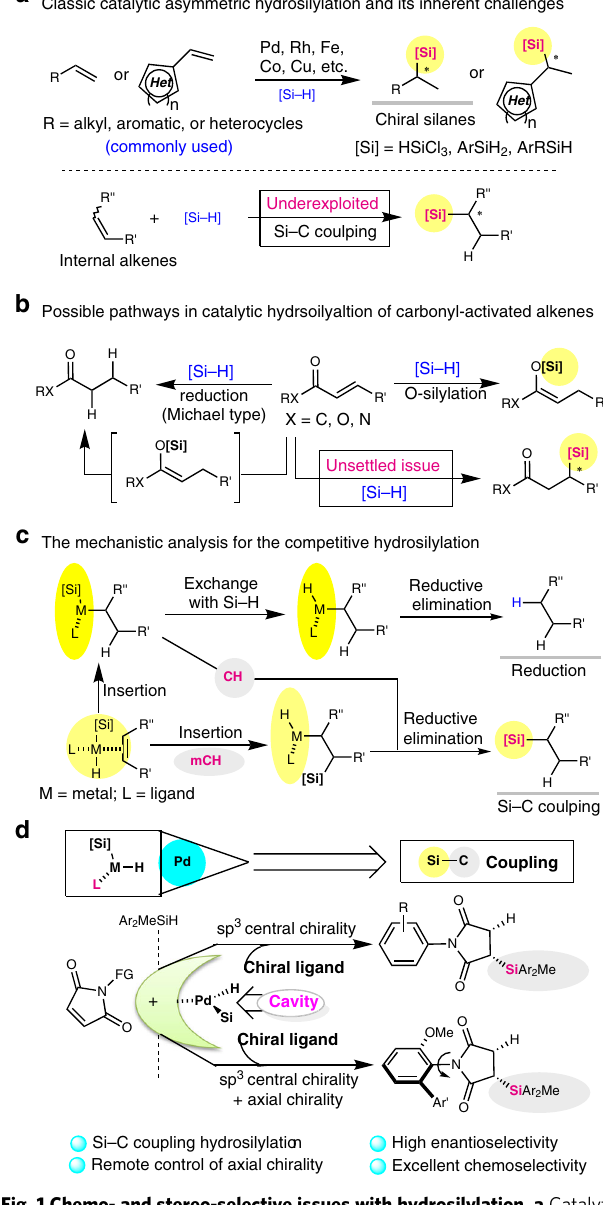
Fig. 1 Chemo- and stereo-selective issues with hydrosilylation. a Catalytic asymmetric hydrosilylation of terminal alkenes mediated by transition- metal catalysts. b Traditional methods for hydrosilylation of EWG-activated alkenes led to reduction and O -silylation. c Two classic pathways for transition-metal-catalysed hydrosilylation of alkenes, and its mechanistic analysis should encourage greater adoption of Si – C coupling methods for the hydrosilylation of internal alkenes. d The catalytic desymmetric hydrosilylation of N -arylmaleimides for remote control of axial chirality. CH is Chalk – Harrod mechanism, and mCH is modi fi ed Chalk – Harrod